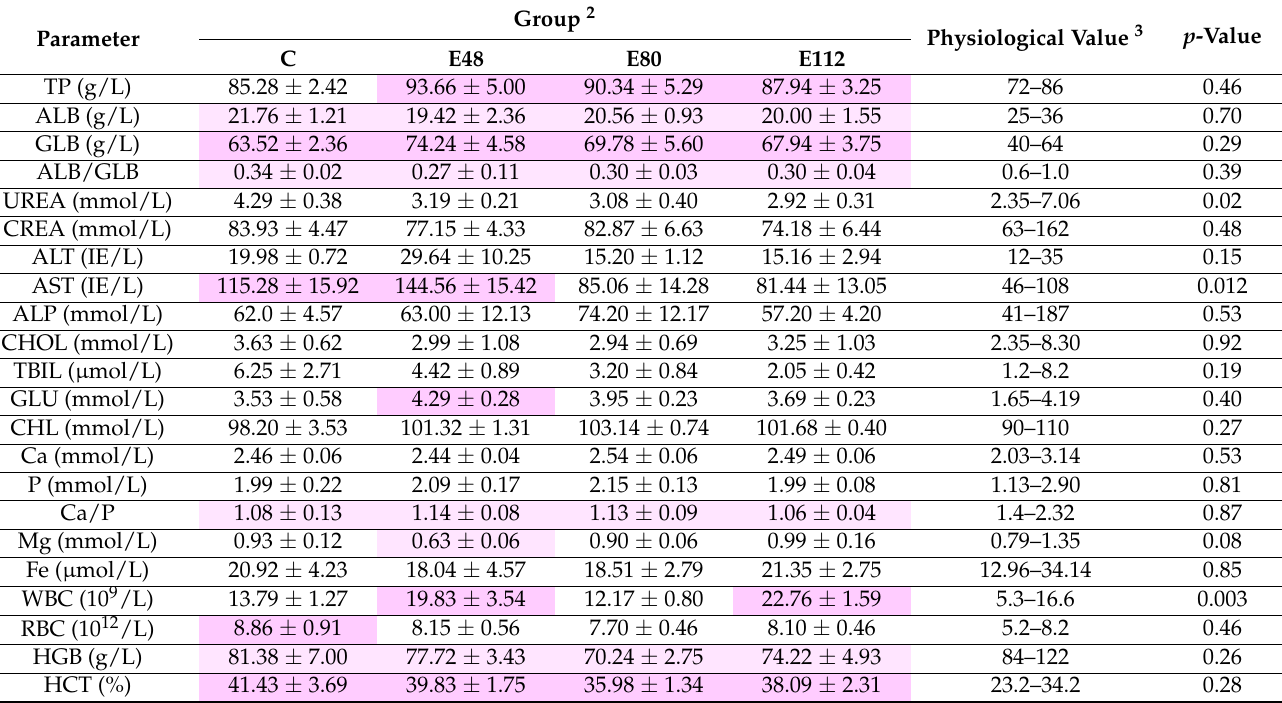
1 Means (±standard error) within a row (overall) followed by different superscript are significantly different, general linear model (GLM), p < 0.05, least significant difference test. 2 C = 0 g, E48 = 48 g, E80 = 80 g, E112 = 112 g, levels of supplement BFA. For each group, n = 5. Marked: